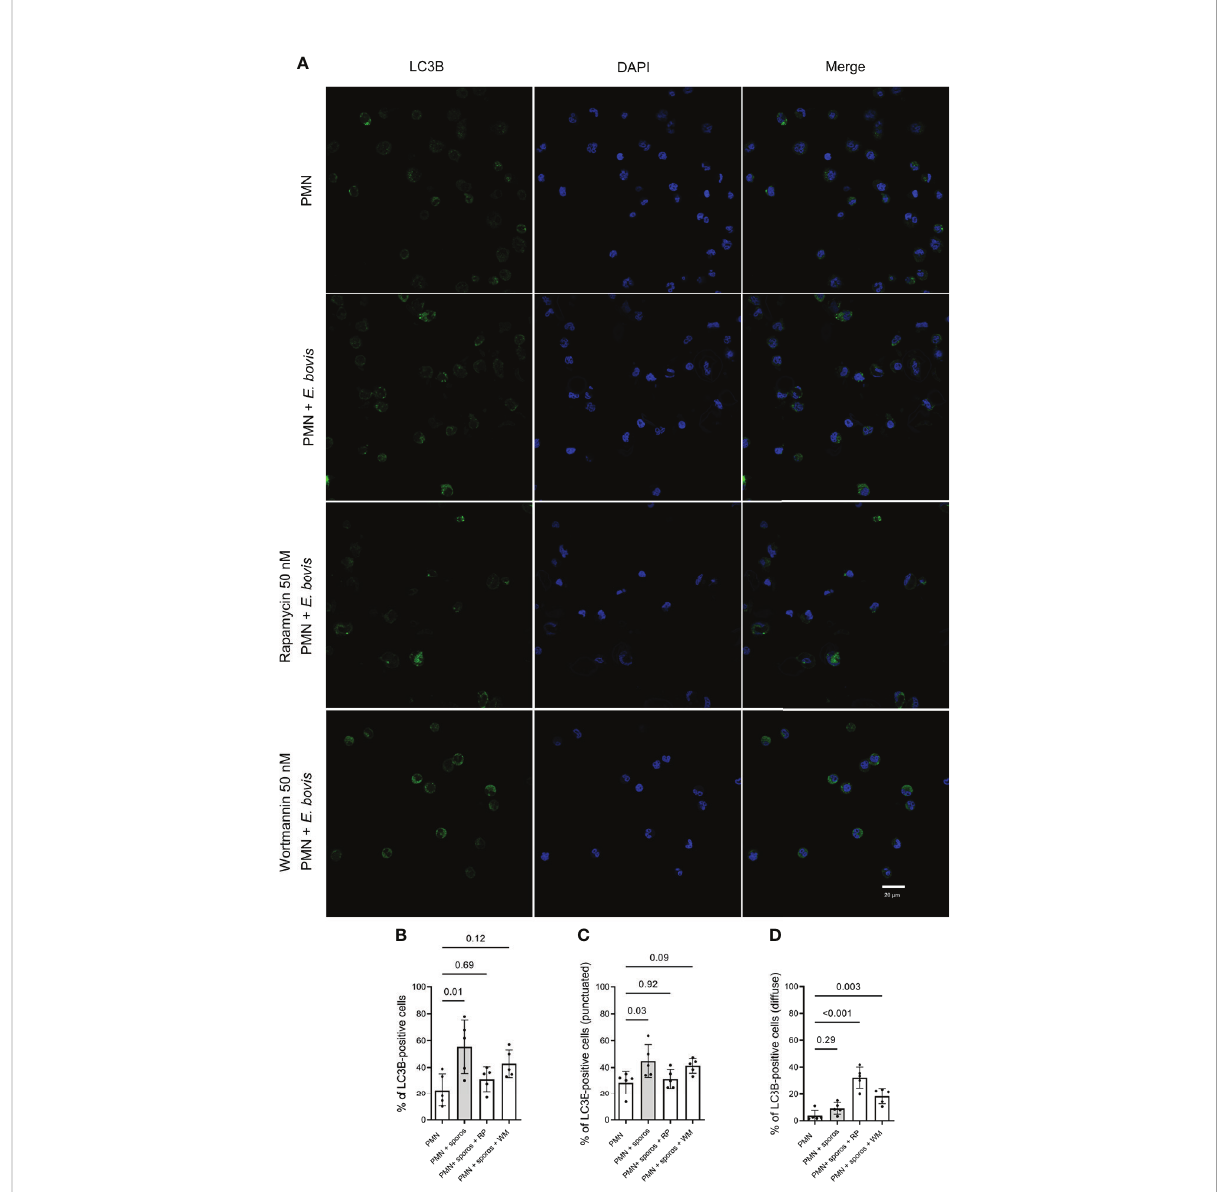
FIGURE 3 LC3B-based autophagosome formation in bovine E. bovis sporozoite-exposed PMN. Panel showing the staining for LC3B (green), DAPI (blue) phase-contrast (grayscale), and merge (A) . Also, PMN were pretreated with rapamycin (RP) or wortmannin (WT) (both 50 nM for 30 min) and then exposed to E. bovis sporozoites or plain medium (PMN). After 2 h of incubation, the samples were stained for LC3B and DNA and the number of autophagosome-positive cells was determined (B) . Also, the punctuated (C) or diffuse (D) signal of LC3B was analyzed. p-values were calculated using a repeated measures (paired) ANOVA followed by a Dunnett ’ s multiple-comparison test analysis (n =